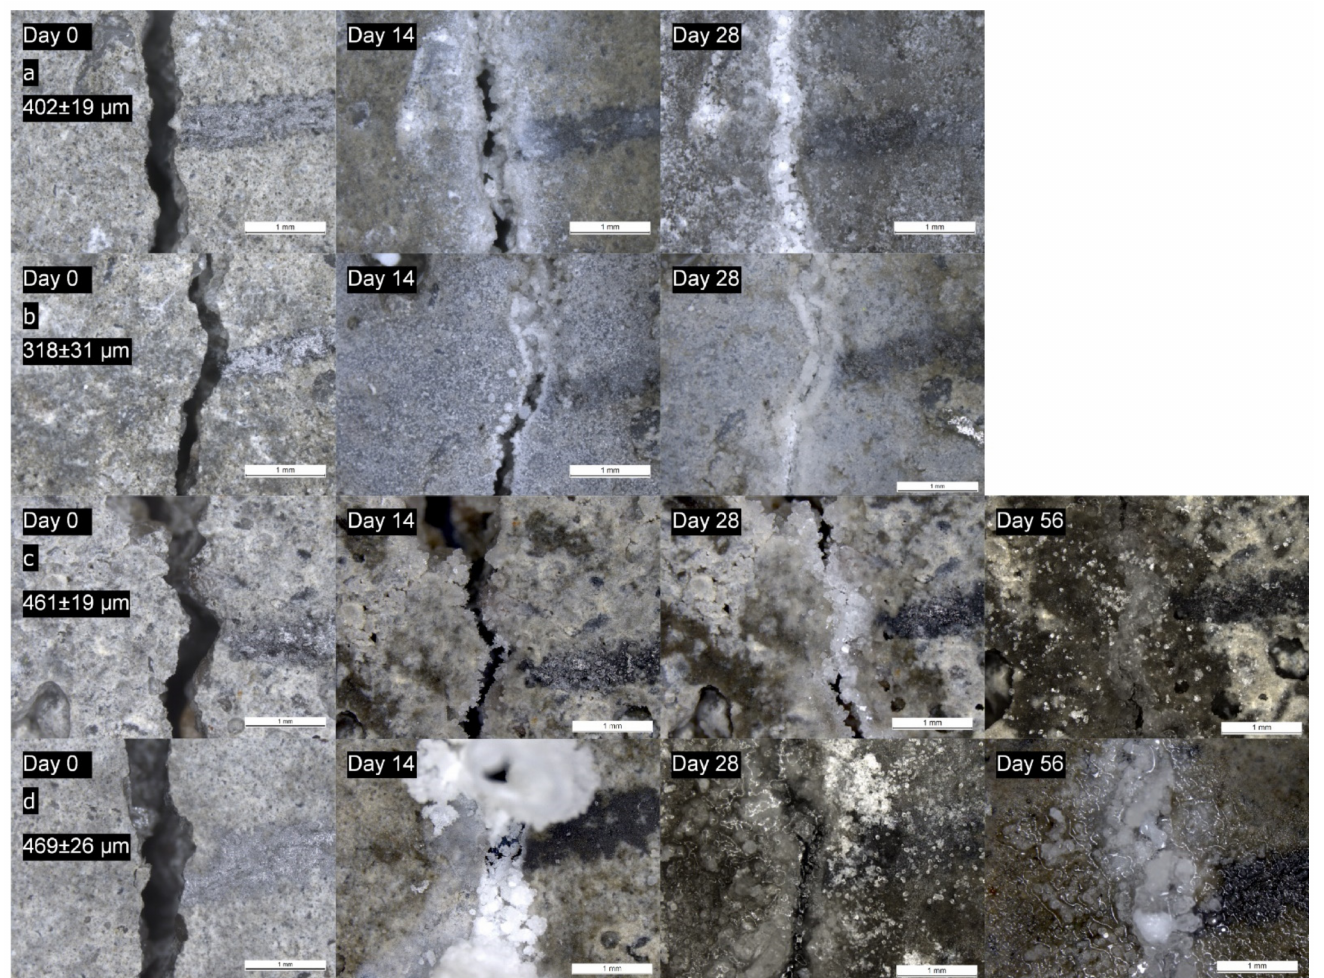
Figure 3. Representative photomicrographs of crack healing in microbial nitrate reduction based self-healing concrete containing ( a ) Diaphorobacter nitroreducens and ( b ) Pseudomonas aeruginosa loaded expanded clay particles; ( c ) Diaphorobacter nitroreducens and ( d ) Pseudomonas aeruginosa loaded granular activated carbon particles (redrafted after Ersan et al.